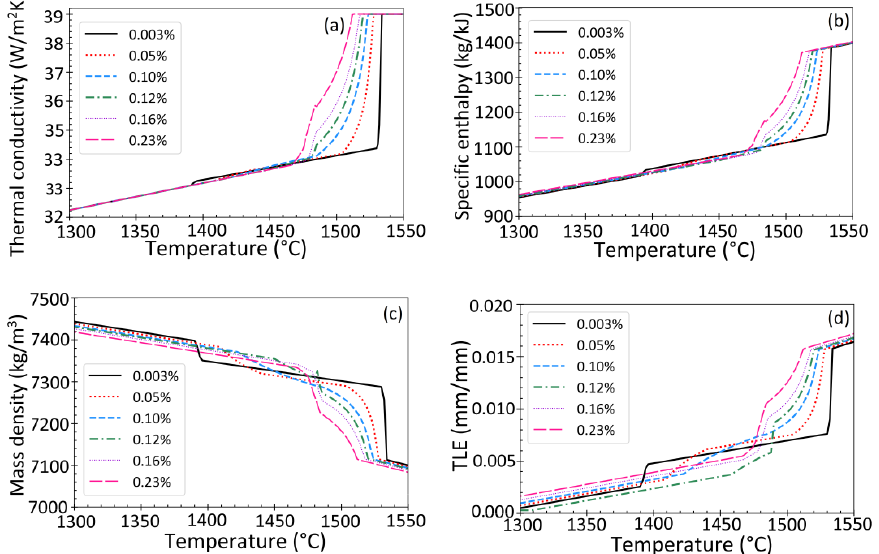
Figure 3. Temperature-dependent properties of six steel grades investigated: ( a ) thermal conductivity; ( b ) specific enthalpy; ( c ) mass density, and ( d ) thermal linear expansion. ( b ) specific enthalpy; ( c ) mass density, and ( d ) thermal linear